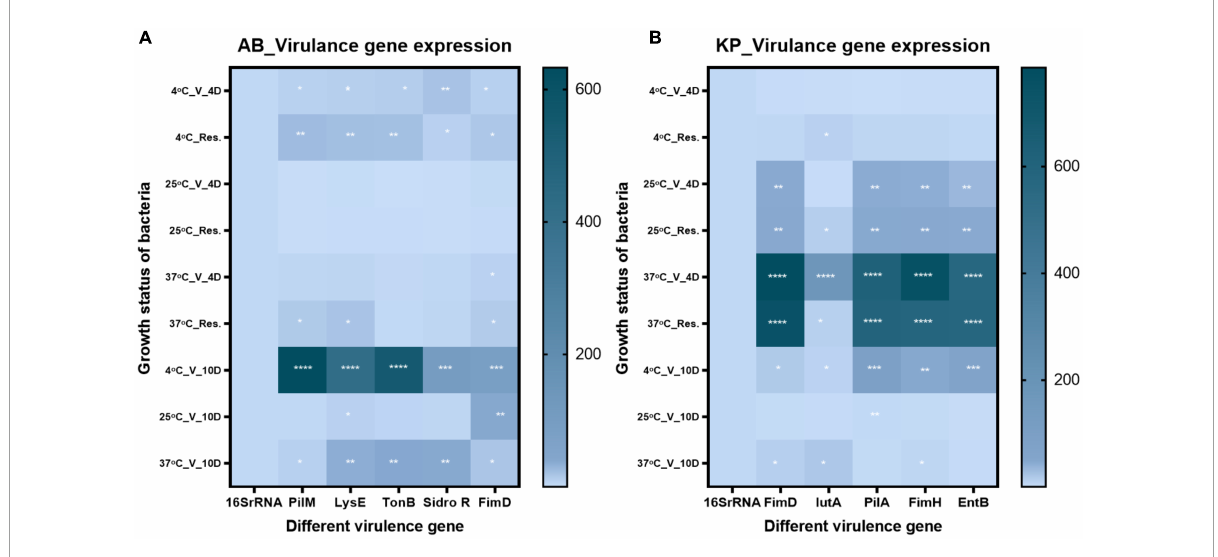
FIGURE8 Virulence gene expression Virulence gene expression was checked in viable-but-non-culturable (VBNC) state after 4- and 10 day treatment and resuscitated bacteria from 4 day VBNC. (A) The expression pattern in Acinetobacter baumannii and (B) expression pattern in Klebsiella pneumoniae . Upregulation of virulence genes in VBNC and resuscitated forms incubated at 4–37 ◦ C on days 4 and 10 was observed. While constant expression of virulence genes was observed in 25 ◦ C incubated VBNC and resuscitated forms. The statistical significance of fold change was determined by two-way ANOVA with multiple comparison followed by correction with Dunnett’s multiple comparison test using GraphPad Prism version 9.0.0. V, VBNC; Res, resuscitated; 4C_V_4D, day 4 VBNC at 4 ◦ C and FA; 25C_V_4D, day 4 VBNC at 25 ◦ C and FA; 37C_V_4D, day 4 VBNC at 37 ◦ C and FA; 4C_Res_4D, day 4 resuscitated from 4 ◦ C and FA induced VBNC; 25C_Res_4D, day 4 resuscitated from 25 ◦ C and FA induced VBNC; 37C_Res_4D, day 4 resuscitated from 37 ◦ C and FA induced VBNC; 4C_V_10D, day 10 VBNC at 4 ◦ C and FA; 25C_V_10D, day 10 VBNC at 25 ◦ C and FA; 37C_V_10D, day 10 VBNC at 37 ◦ C and FA. * P -valve < 0.5, ** P -valve < 0.05, *** P -valve < 0.005, and **** P -valve <